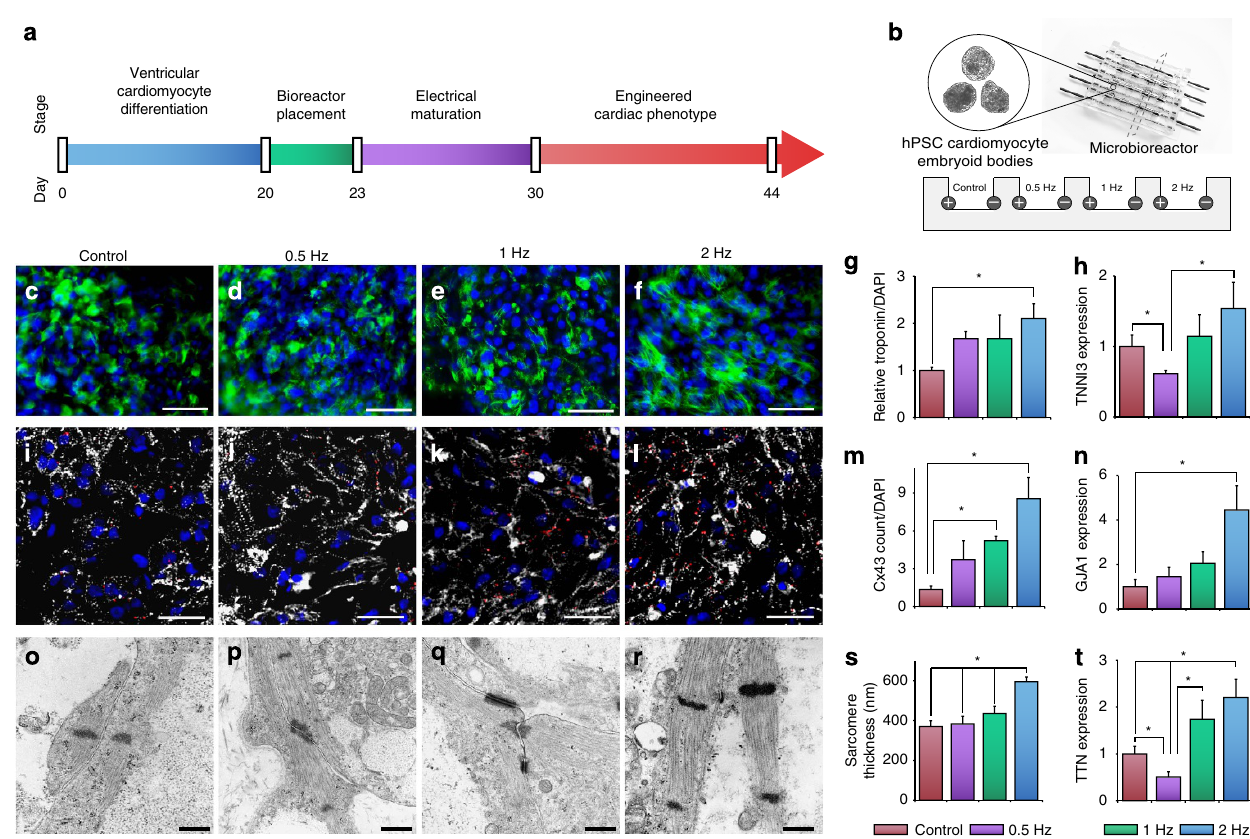
Figure 1 | Electrical stimulation matures stem cell-derived cardiomyocytes. ( a ) Staged differentiation protocol for generating cardiomyocytes from hESCs or iPSCs. Cells were differentiated for 20 days, electrically stimulated for 7 days and taken off stimulation for 14 days to examine the lasting effects of electrical stimulation. ( b ) Schematic of microbioreactor set-up. Differentiated hESC- or iPSC-derived cardiomyocytes were placed into a polydimethylsiloxane bioreactor between parallel carbon rods with stimulation groups: unstimulated, 0.5, 1 and 2Hz. ( c – g ) Immunostains demonstrating increasing levels of troponin (green) and improved organization with increasing frequency of stimulation. Slides were counterstained with 4,6-diamidino- 2-phenylindole (DAPI, blue). Scale bar, 50 m m; n Z 3. ( h ) Quantitative PCR of TNNI3 shown as a fold change relative to the control (average ± s.e.m., n Z 3). ( i – m ) Immunostains demonstrating increasing levels of connexin-43 (red) with increasing rate of stimulation. Slides were counterstained with a -actinin (grey) and DAPI (blue). Scale bar, 25 m m; n Z 3. ( n ). Quantitative PCR of GJA1 (average ± s.e.m. of fold change relative to control, n Z 3). ( o – r ) Transmission electron microscopy at (cid:3) 20,000. Scale bar, 500nm. ( s ) Sarcomere thickness (nm ± s.e.m; n ¼ 8–14). ( t ) Quantitative PCR of TTN shown as a fold change relative to control ± s.e.m. *Statistically significant differences between the individual groups or between multiple groups ( n Z 3, P o 0.05, one-way analysis of variance (ANOVA) with post hoc Tukey